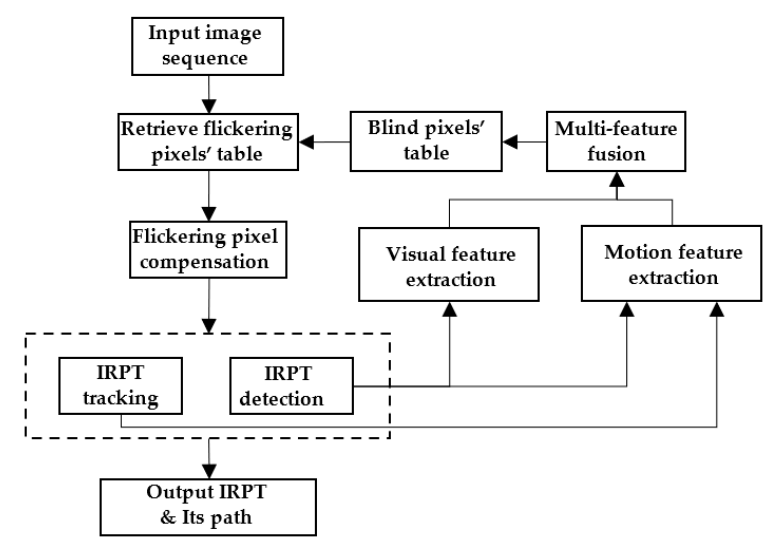
Figure 1. The block diagram of proposed algorithm.